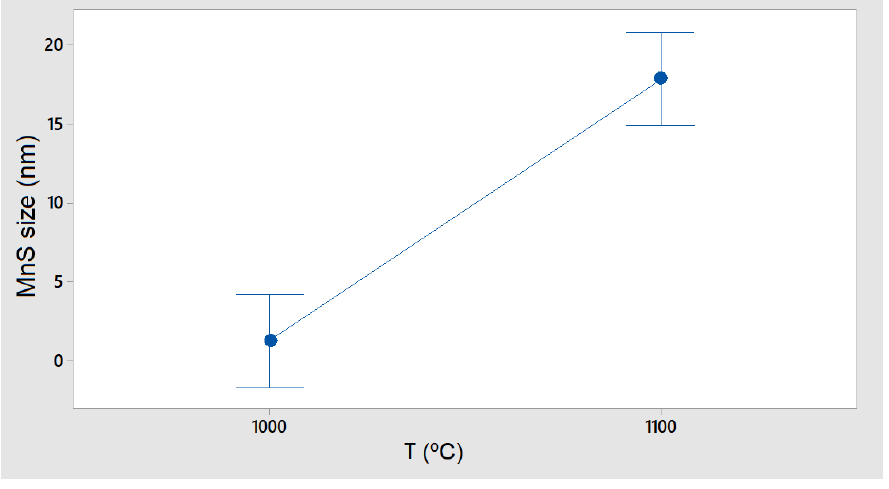
Figure 13. DOE Thermocalc simulation for MnS precipitates’ size in nanometers as a function of T ( ◦